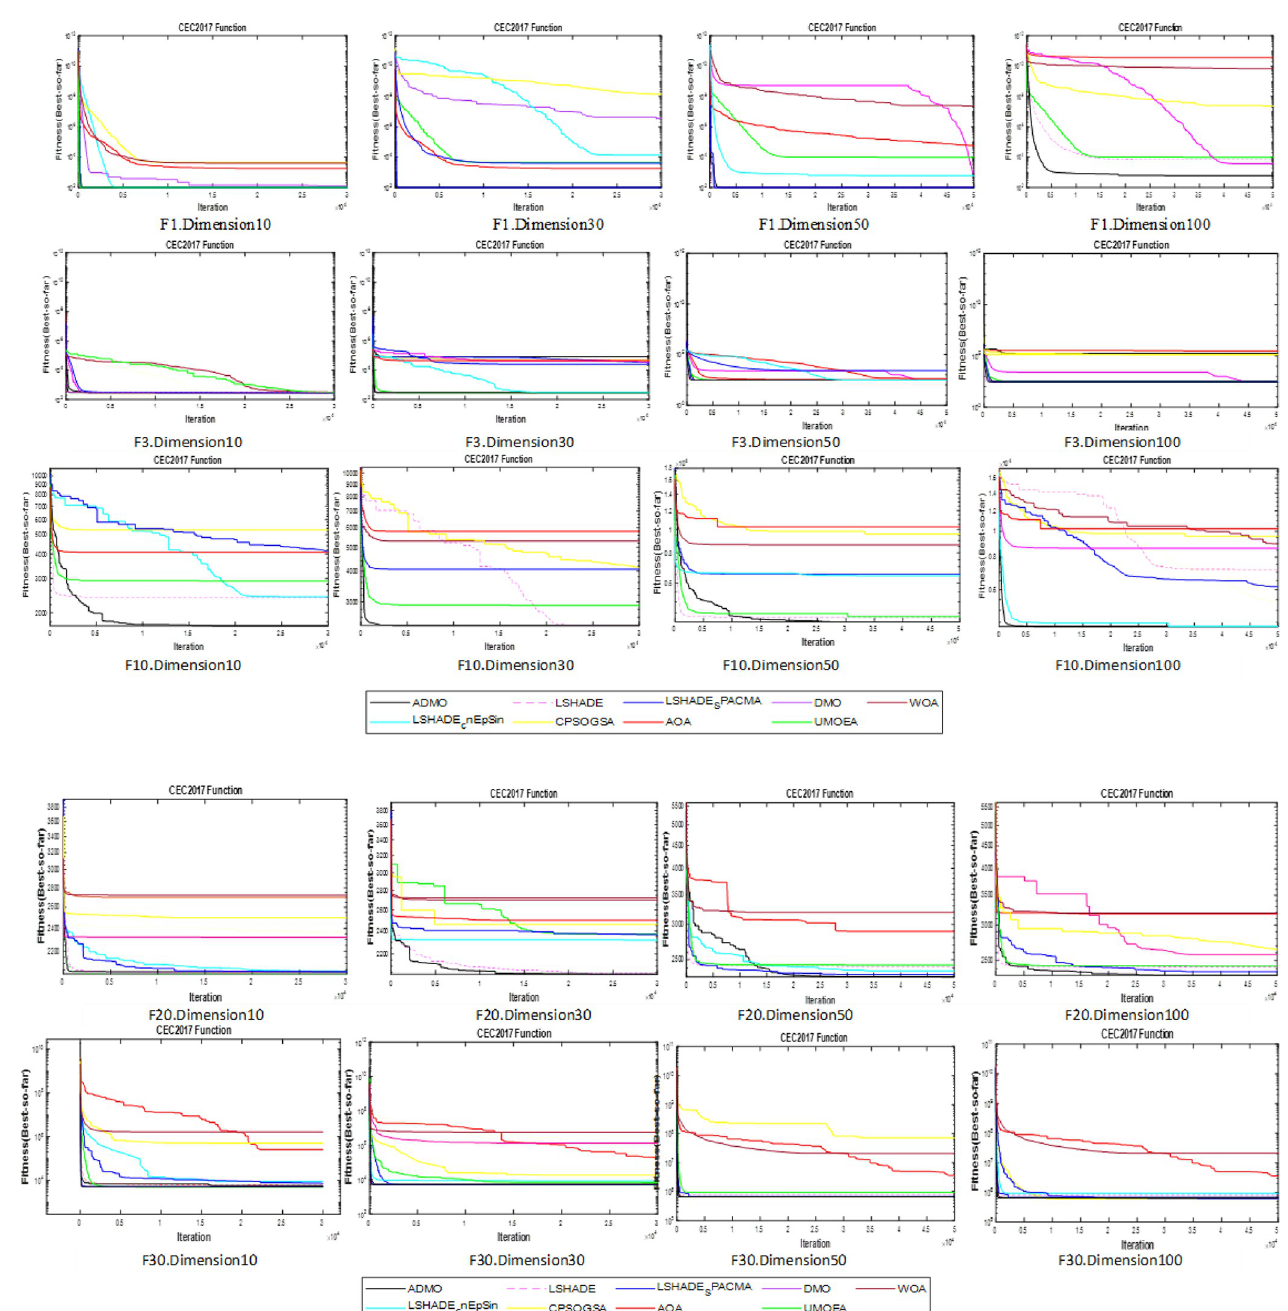
Fig 6. Convergence behavior of selected CEC 2017 functions. better, the same, or less than the other algorithms in 171, 35, 26 out of 232 cases. Similarly, the ADMO performed better, the same, less than the other algorithms in 167, 52, 13 out of 232 cases for 50 dimensions. Finally, for 100 dimensions, the ADMO performed better, the same, less than the other algorithms in 168, 52, 12 out of 232 cases. Overall, the ADMO performed better, the same, less than the other algorithms in 644, 142, 142 out of 928 cases.